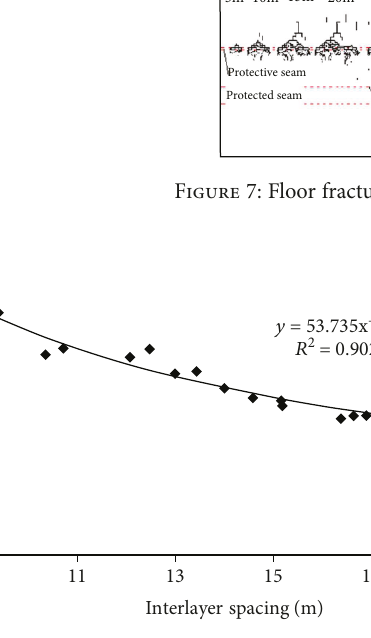
Figure 8: Scatter diagram of the ventilation air methane for PSWF4216. Figure 9: The measured data and the theoretical curve of